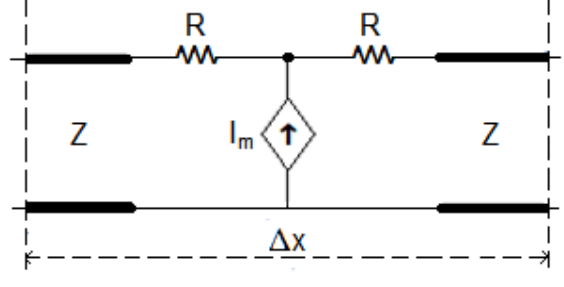
Figure 3. TLM dispersion